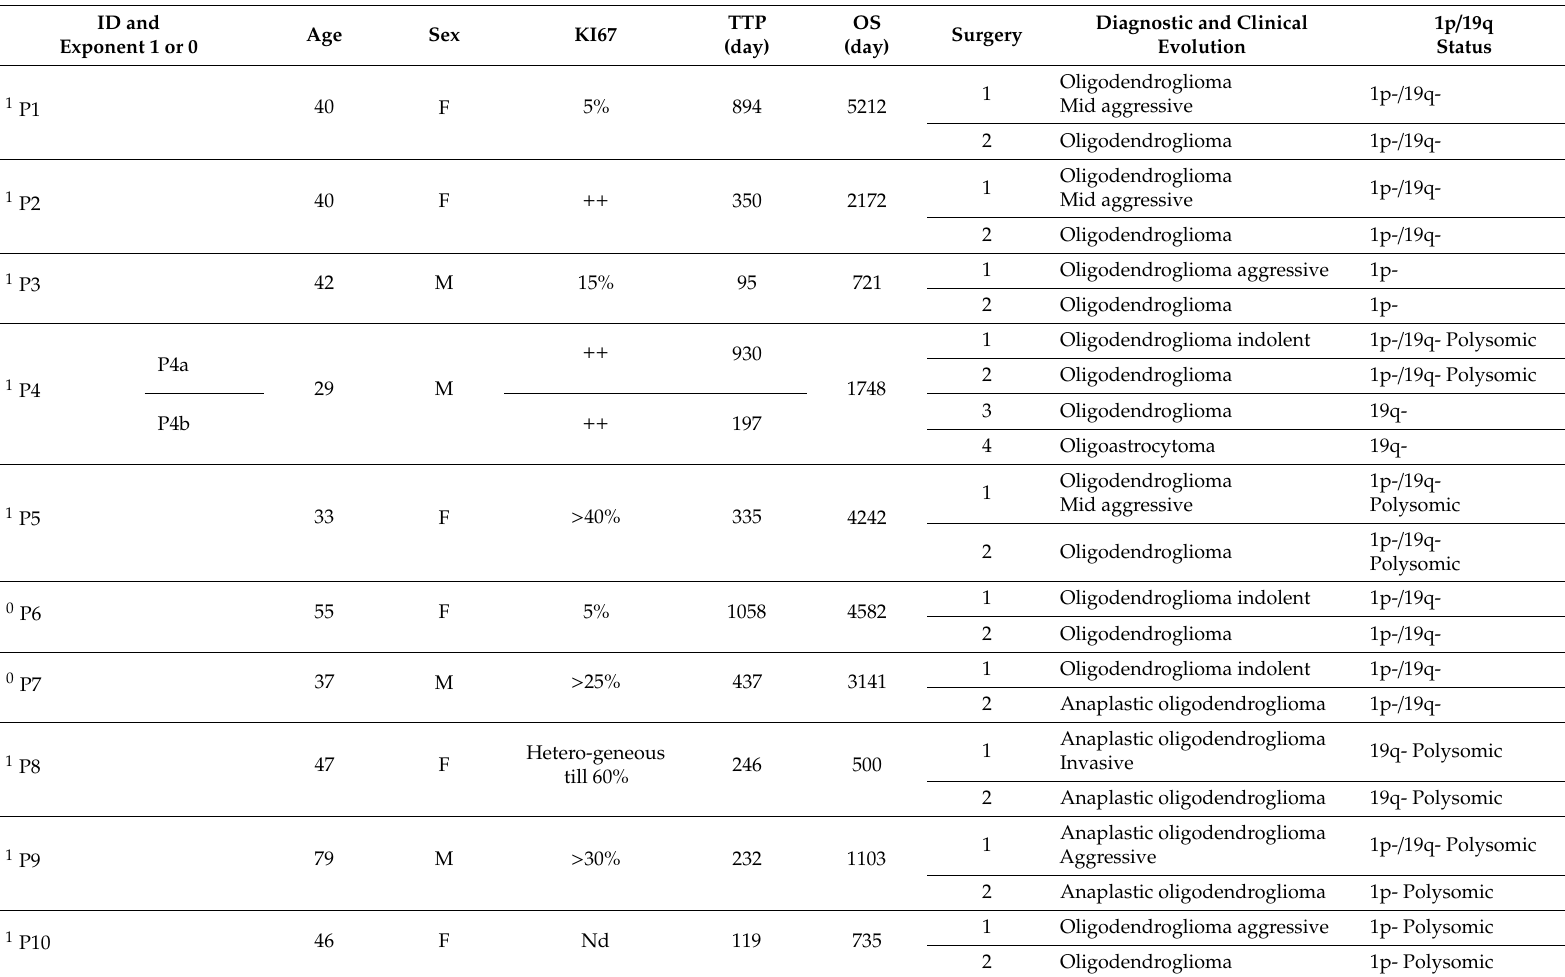
Table 1. Clinical data and FISH of 1p / 19q